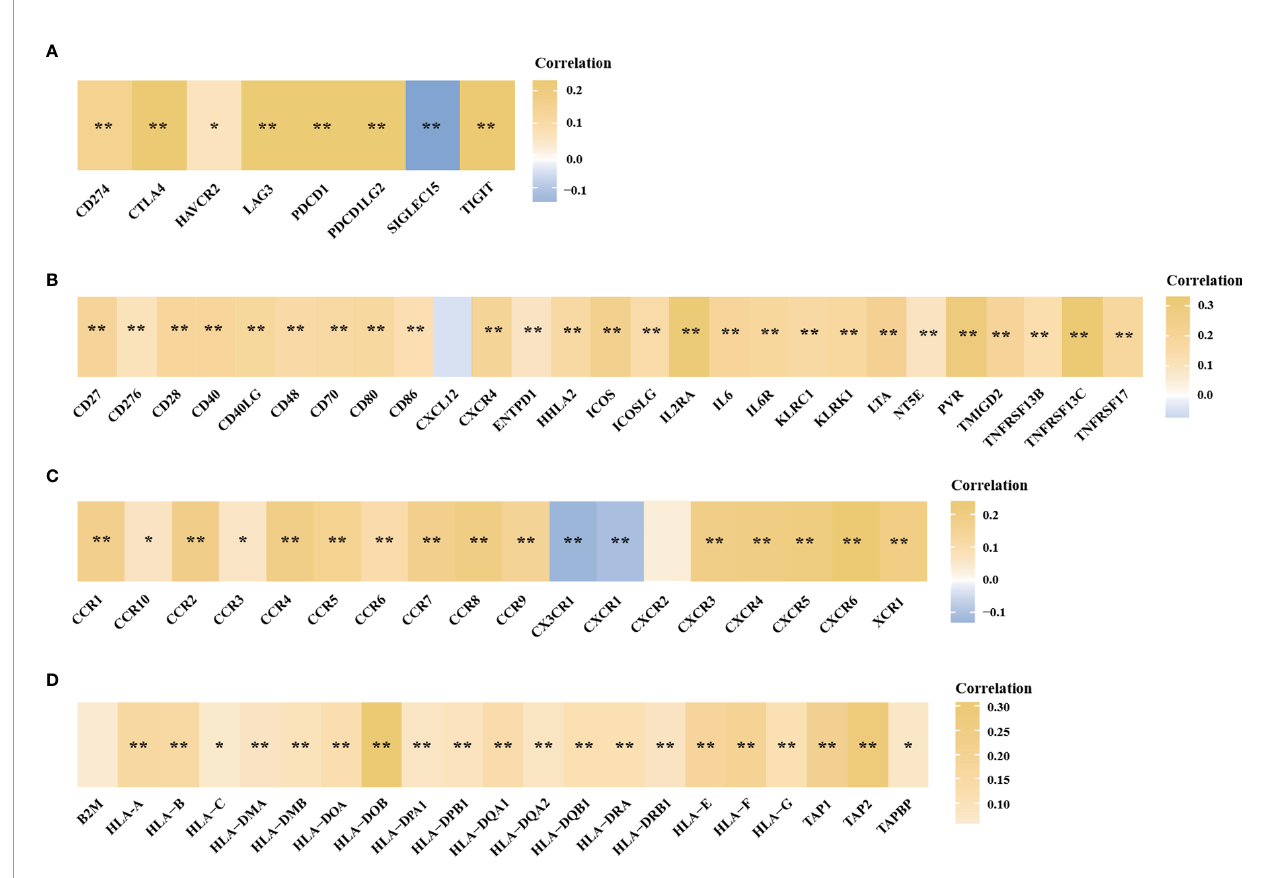
FIGURE 6 | The expression of HTR6 was signi fi cantly correlated with the expression of immune checkpoints, immune stimulators, immune receptors and chemokines. The correlation between HTR6 expression and the expression of (A) immune checkpoints, (B) immune stimulators, (C) immune receptors, and (D) chemokines. “ * ” indicated p value < 0.05, and “ ** ” indicated p value <